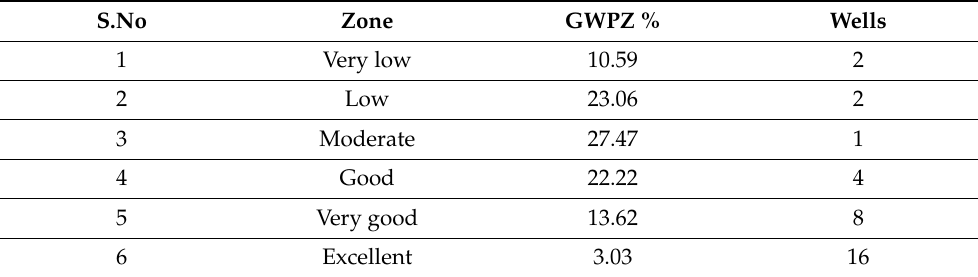
Table 5. GWPZs and well locations in the study